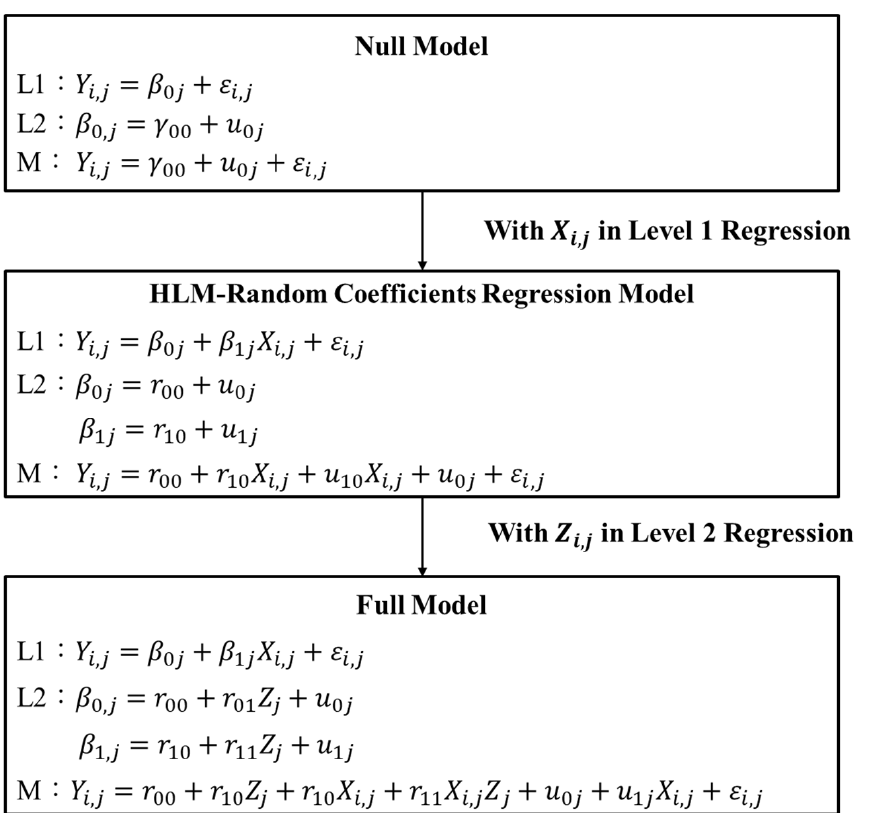
Figure 4. The development process of the HLM. L1 stands for the level 1 regression under the HLM; L2 stands for the level 2 regression under the HLM; M stands for the mixed model under the HLM.